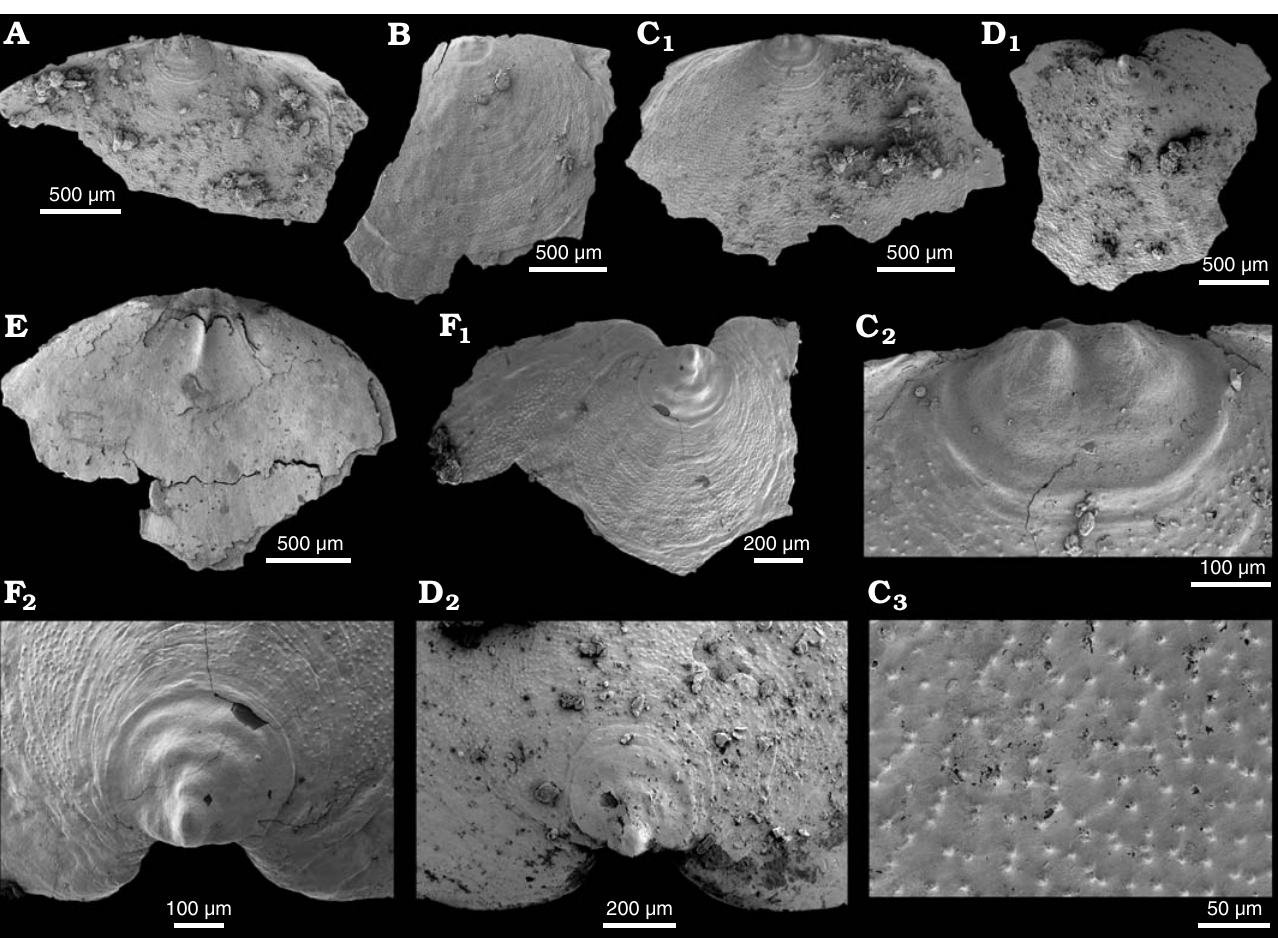
Fig. 9. The lingulid brachiopod Schizopholis yorkensis (Holmer and Ushatinskaya in Gravestock et al., 2001) from the lower Cambrian White Point Conglomerate, Kangaroo Island, South Australia. Dorsal (A–C, E) and ventral (D, F) valves. A . SAM P57270 in external view. B . SAM P57271 in external view. C . SAM P57272 in external view (C 1 ); C 2 , detail of the larval shell; C 3 , external pustulose ornament. D . SAM P57273 in external view (D 1 ); D 2 , de- tail of the larval shell. E . SAM P57274 in internal view. F . SAM P57275 in external view (F 1 ); F 2 , detail of the larval